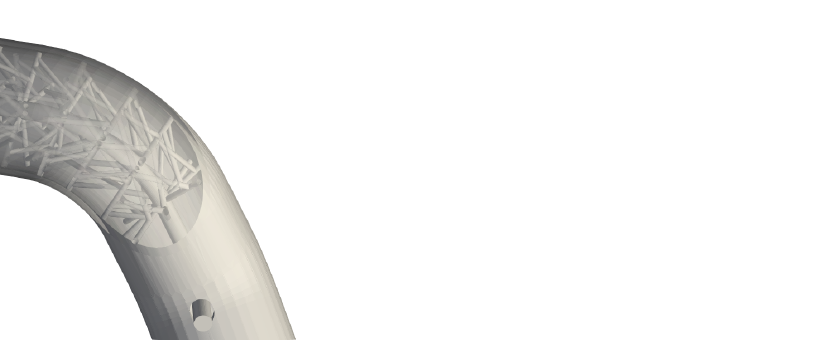
Figure 4. POCS geometrical characterization: visualization of the POCS module section for an increasing axial coordinate.